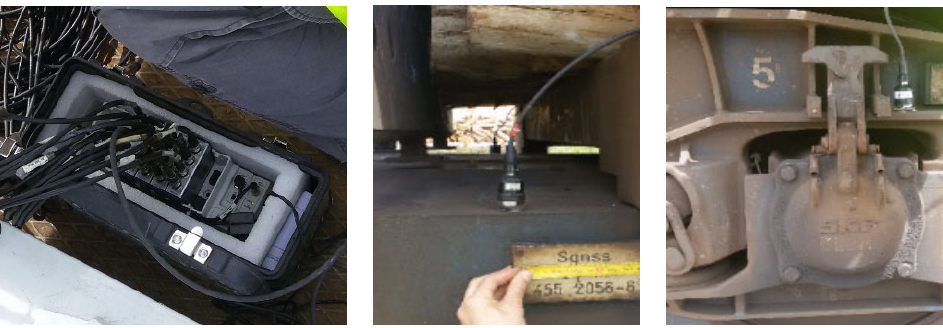
Figure 6. Dynamic tests of Sgnss wagon: measurement setup (reference points in red and mobile points in blue).